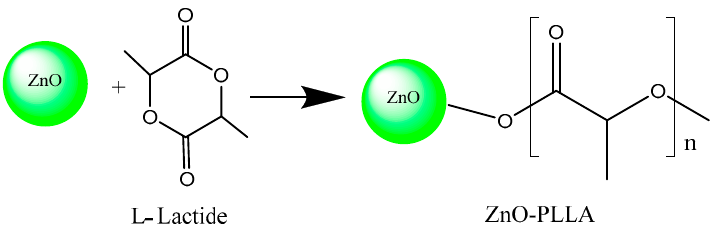
Figure 1. Synthesis route of ZnO-PLLA